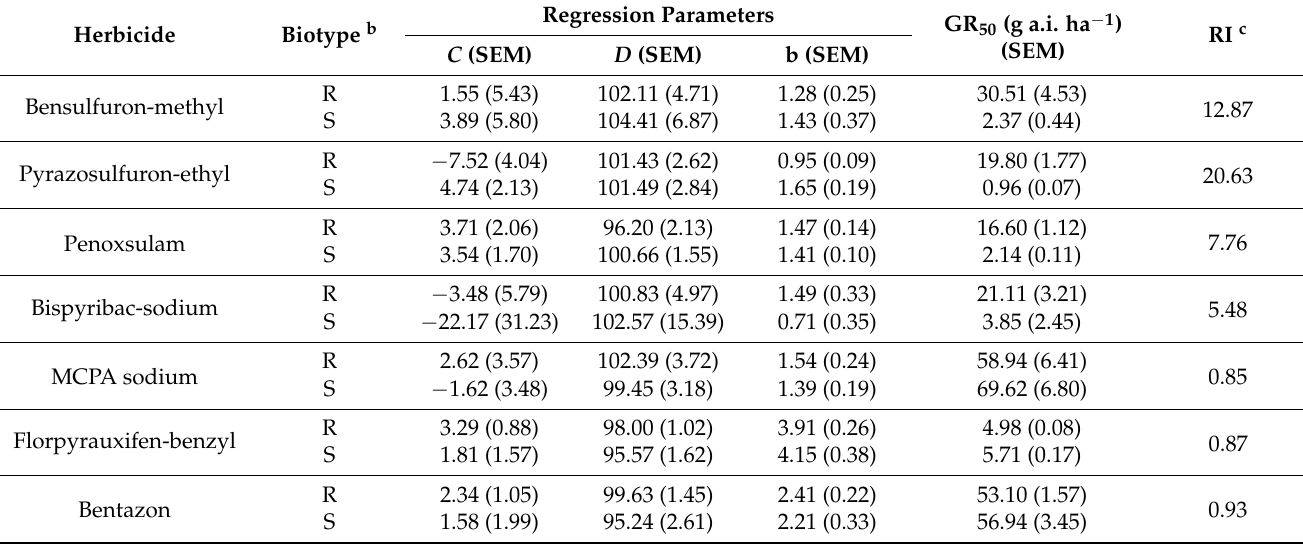
Table 3. Parameters of the log-logistic equation (1) a for whole-plant dose-response of S and R populations for the seven herbicides